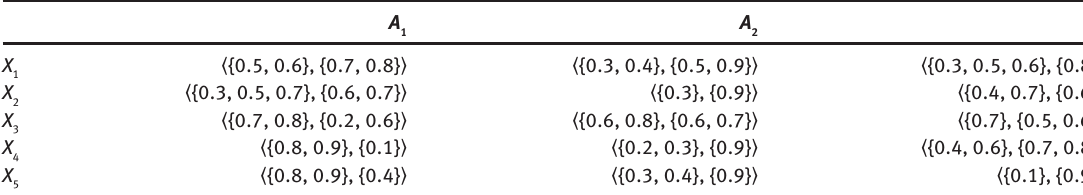
Table 1: Pythagorean Hesitant Fuzzy Decision Matrix C